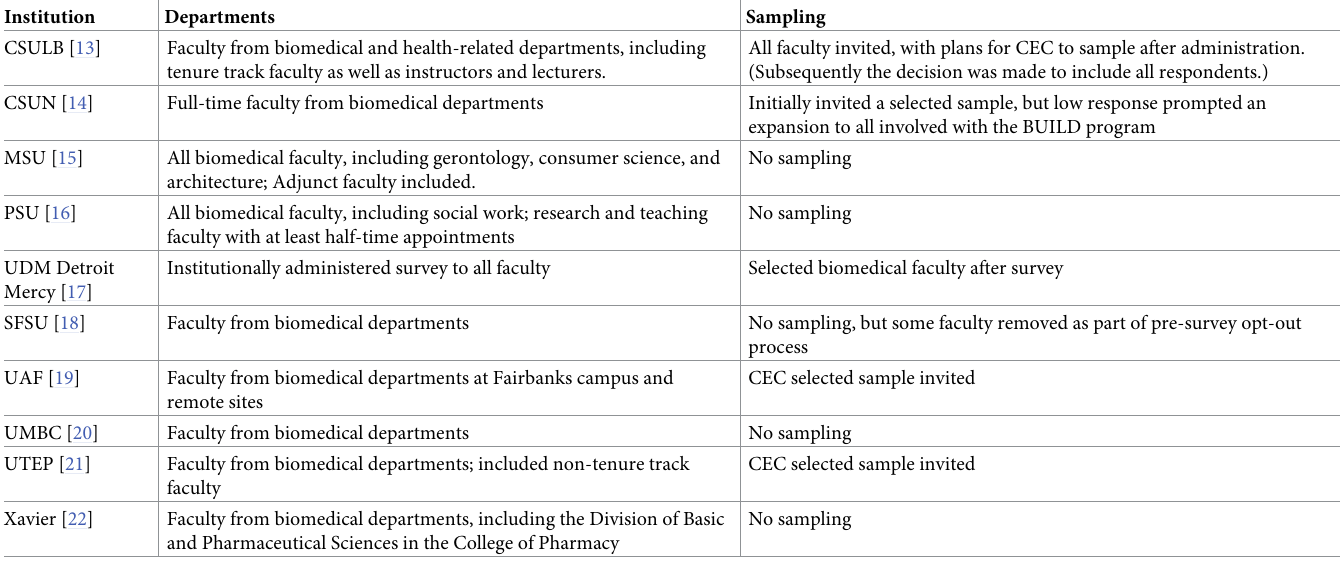
Table 1. Sampling description for HERI faculty survey 2016–2017 by BUILD